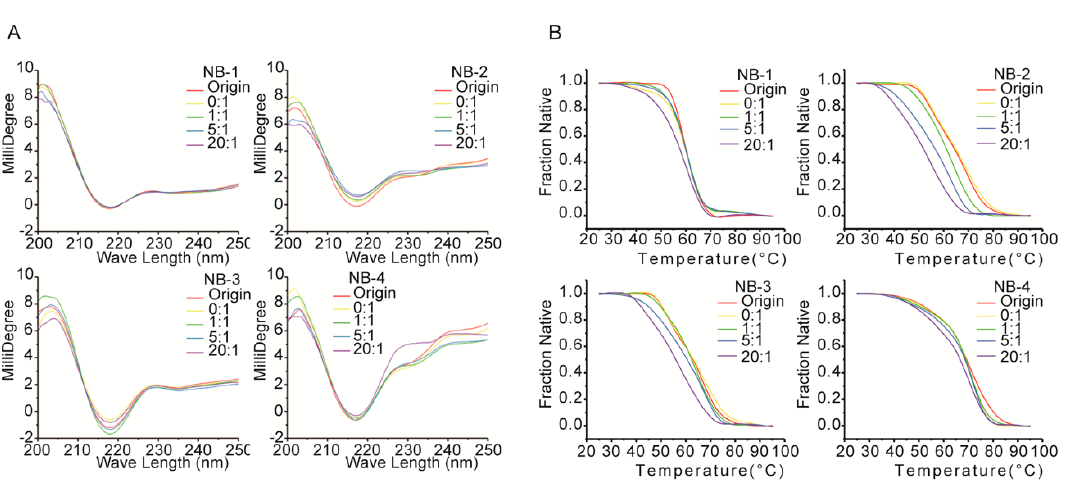
Table 3. Midpoints of the denature profiles of the modified